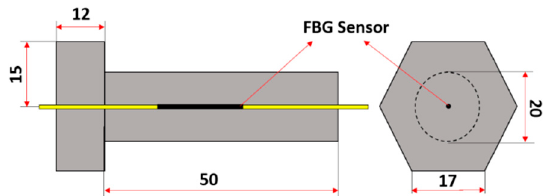
Figure 8. The design of a smart bolt with an embedded FBG sensor.